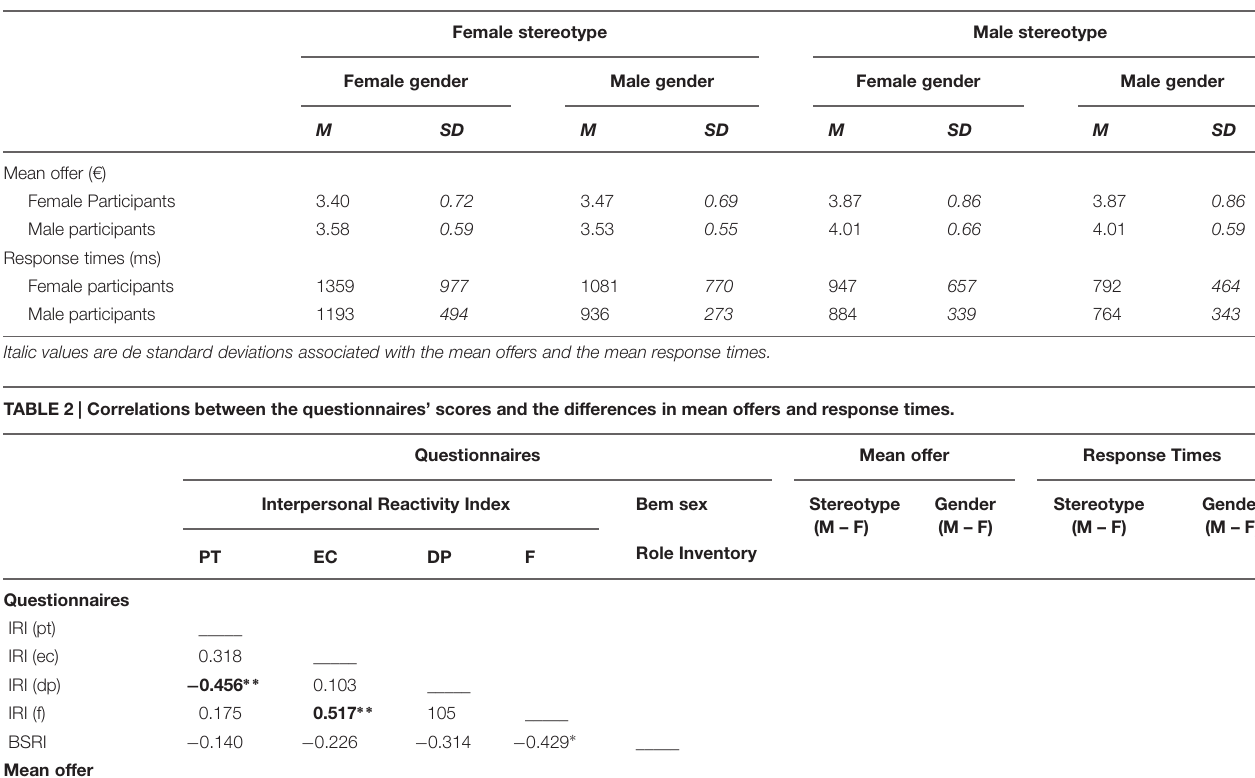
TABLE 1 | Offers and response times means and standard deviations for each experimental condition.